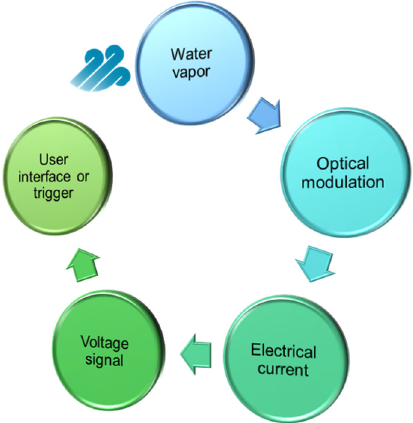
Figure 3. Flow diagram of the operation of a typical optical humidity sensor.